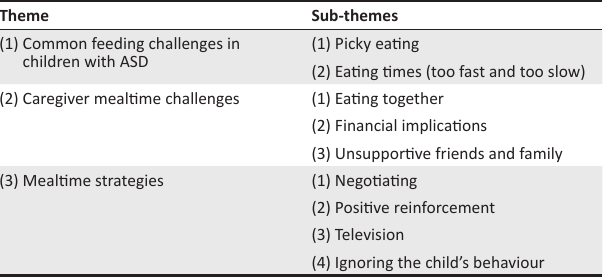
TABLE 2: Themes and